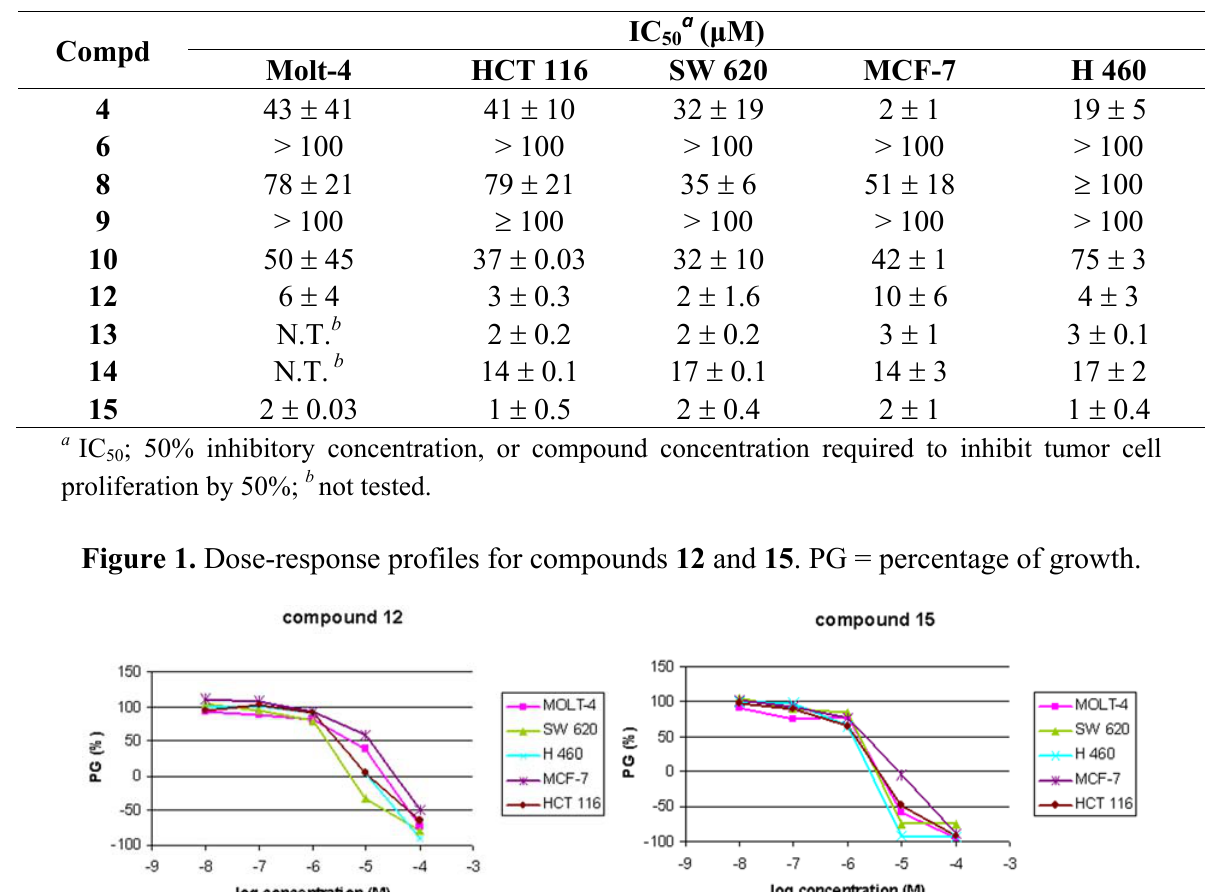
Table 1. Inhibitory effects of compounds 4 , 6 , 8-10 and 12 - 15 on the growth of human tumor cell lines.